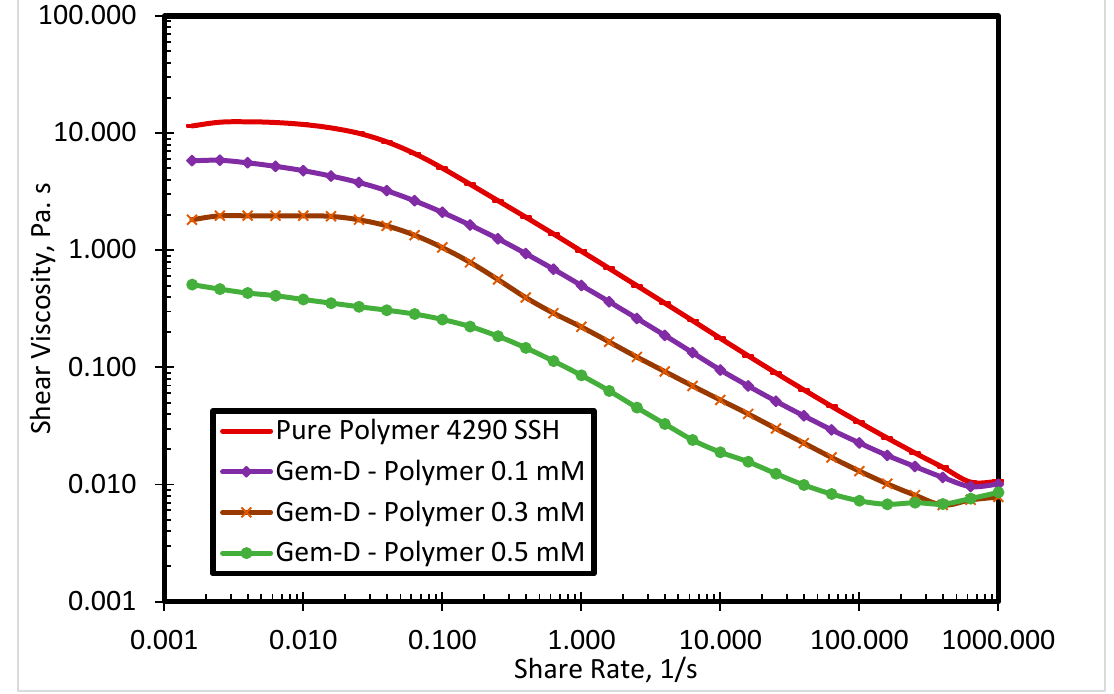
Figure 8. Shear viscosity of 4290 SSH polymer with Gem-D surfactant at different concentrations.